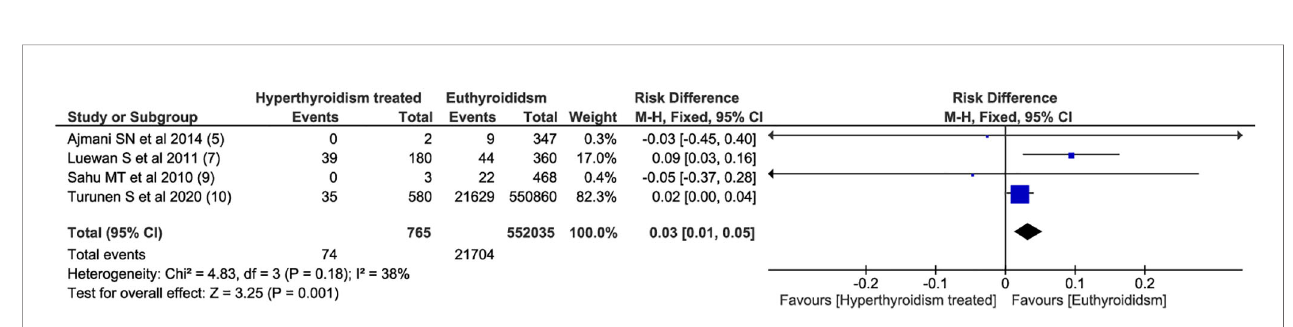
FIGURE 5 | Forest Plot: Premature Birth.